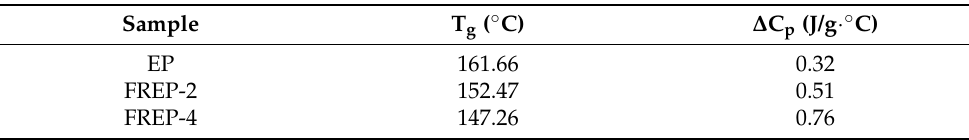
Table 7. T g and ∆ C p values obtained from DSC Table 7. T g and Δ C p values obtained from DSC curves.